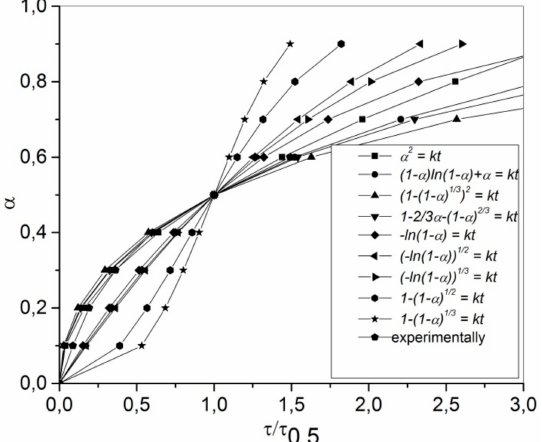
Figure 9. Selection of the kinetic model for linearization of the experimental results.